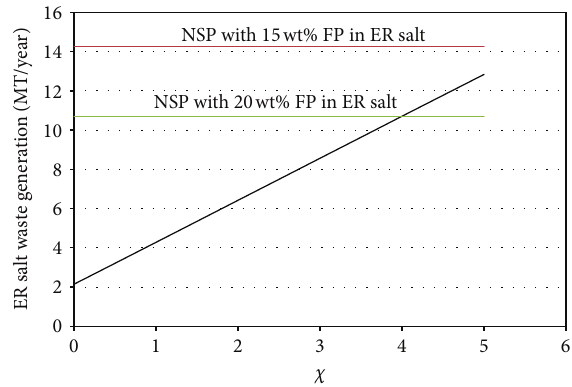
Figure 7: Comparison of ER salt waste generation rates for 100MTHM/year facility for selective process (black curve) to non- selective process (NSP) with two different levels of fission product accumulation in the